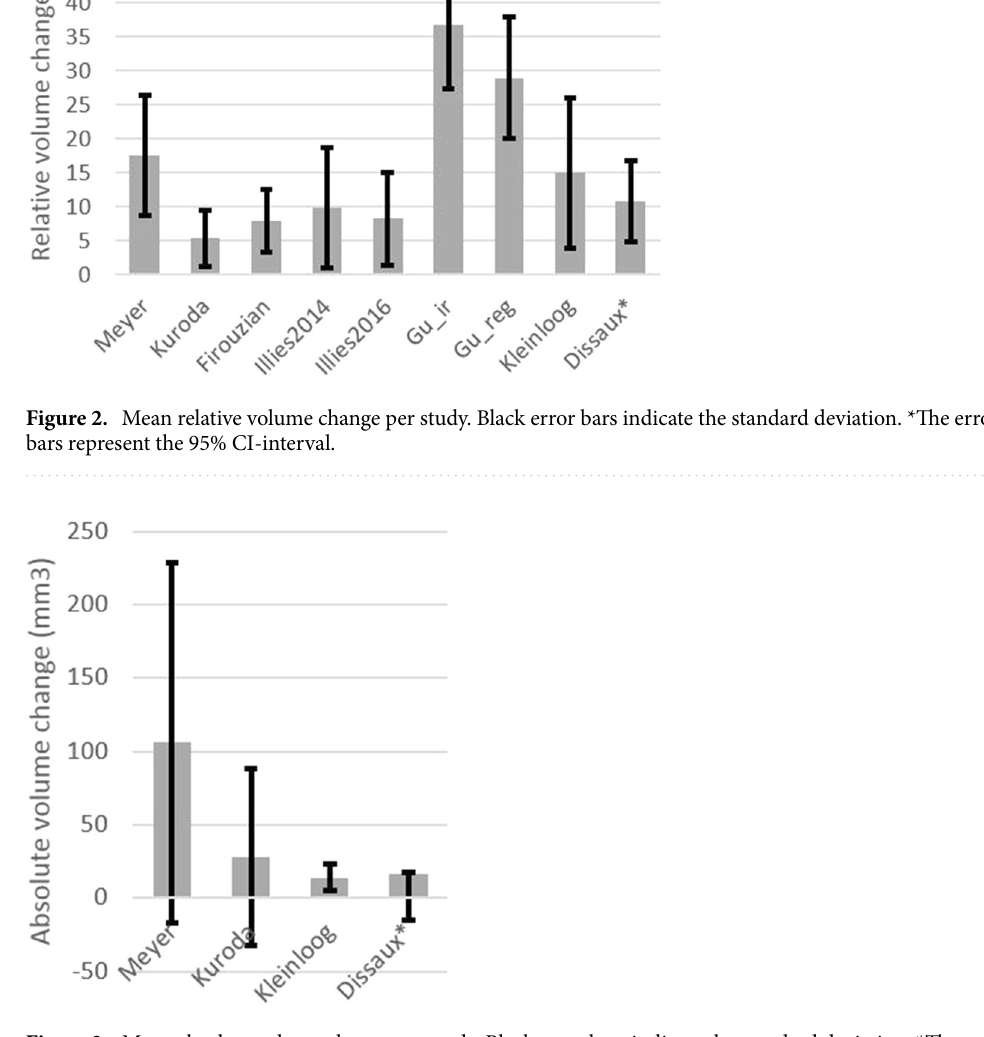
Figure 3. Mean absolute volume change per study. Black error bars indicate the standard deviation. *The error bars represent the 95%